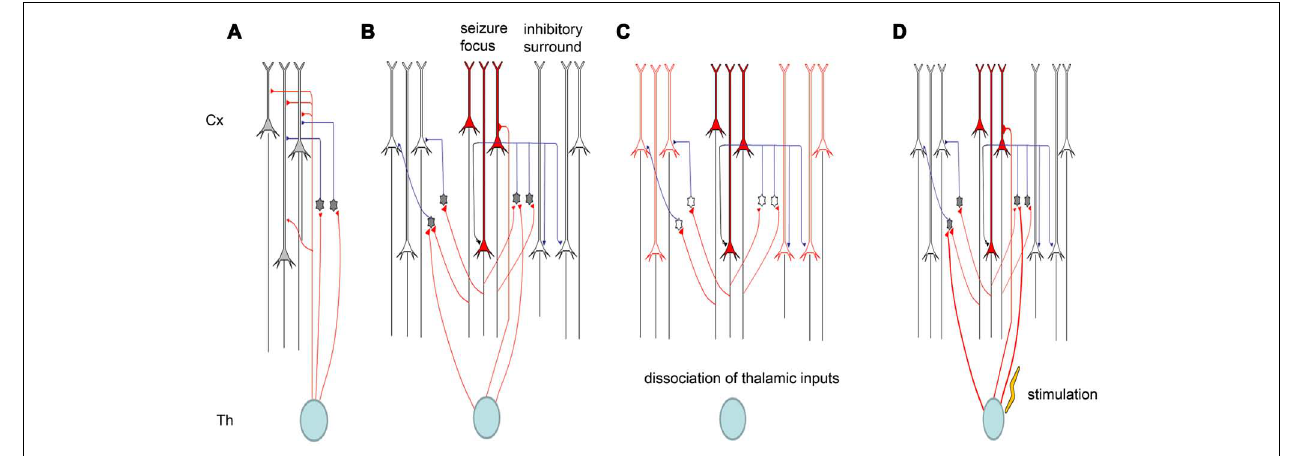
(C) Removing the thalamic inputs also reduces the inputs of inhibitory interneurons, and the weakening of surrounding inhibition facilitates the propagation of epileptiform activity. (D) Electrical stimulation of the thalamus will activate both pyramidal neurons and inhibitory interneurons in cortical areas, but the synapses between thalamic relay neurons and interneurons are stronger than those between thalamic relay neurons and pyramidal neurons. Therefore, electrical stimulation of the thalamus can suppress seizure